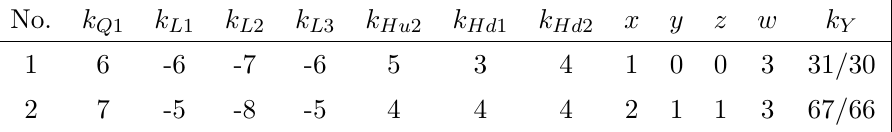
Table 6 . The parameters of the charge assignment ( N h = 2).